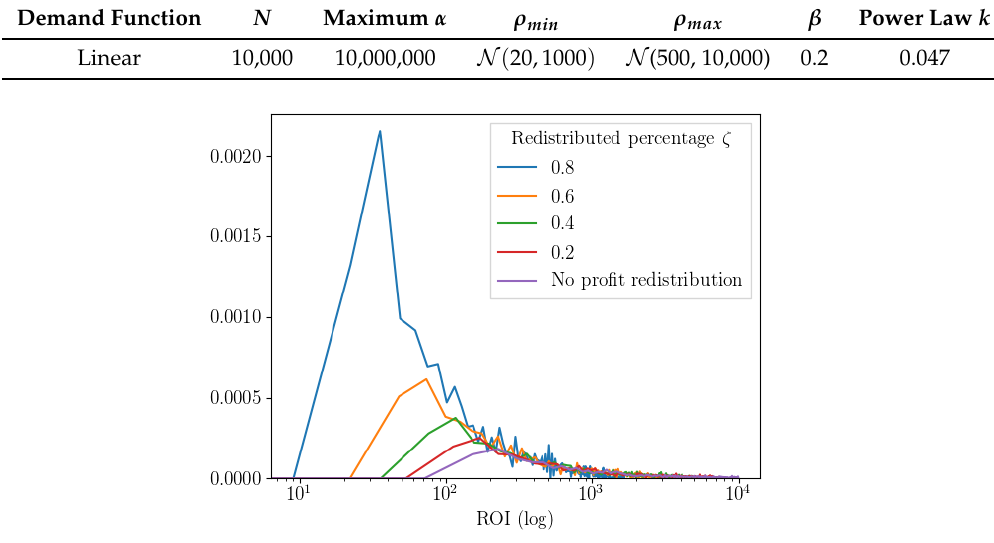
Figure 2. Simulated ROI